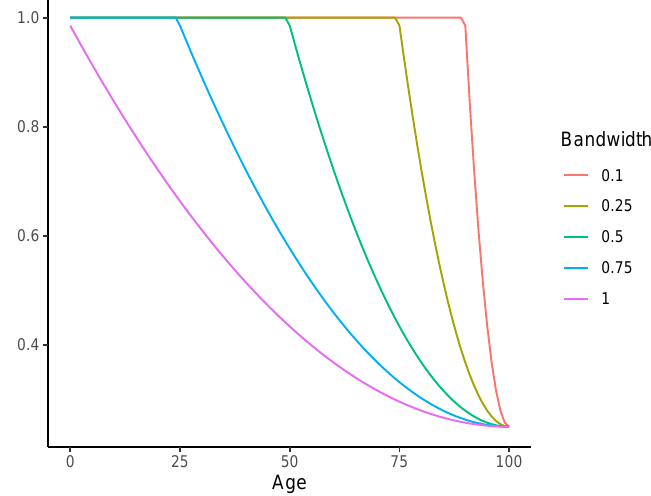
Figure 1. Demonstrations of the inversed Epanechnikov